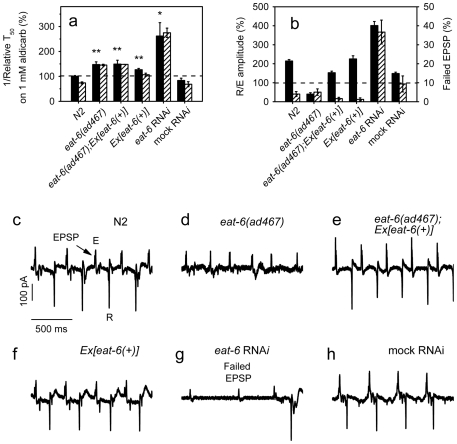
Phenotypic analysis of eat-6 RNAi and overexpression.(a) Relative reciprocal T50 values of aldicarb-induced paralysis of animals untreated (black bars) or pretreated with 5-HT (hatched bars). The error bars indicate SEM (n>3 replicates). Both RNAi and overexpression of eat-6 conferred hypersensitivity to aldicarb compared to WT (* p<0.05, ** p<0.01). Pretreatment of 5-HT reduced aldicarb sensitivity in WT animals (p<0.005), but not in eat-6 RNAi animals. Student's t-test. (b) The ratio of the amplitude of the excitation and recovery peaks (black bars, left axis), and the fraction of EPSPs that failed to trigger APs (hatched bars, right axis). The error bars indicate SEM (n = 15). (c–h) Representative EPG recordings. EPSP designates an excitatory postsynaptic potential, E designates the peak corresponding to the muscle excitation (depolarization), R designates the peak corresponding to muscle recovery.